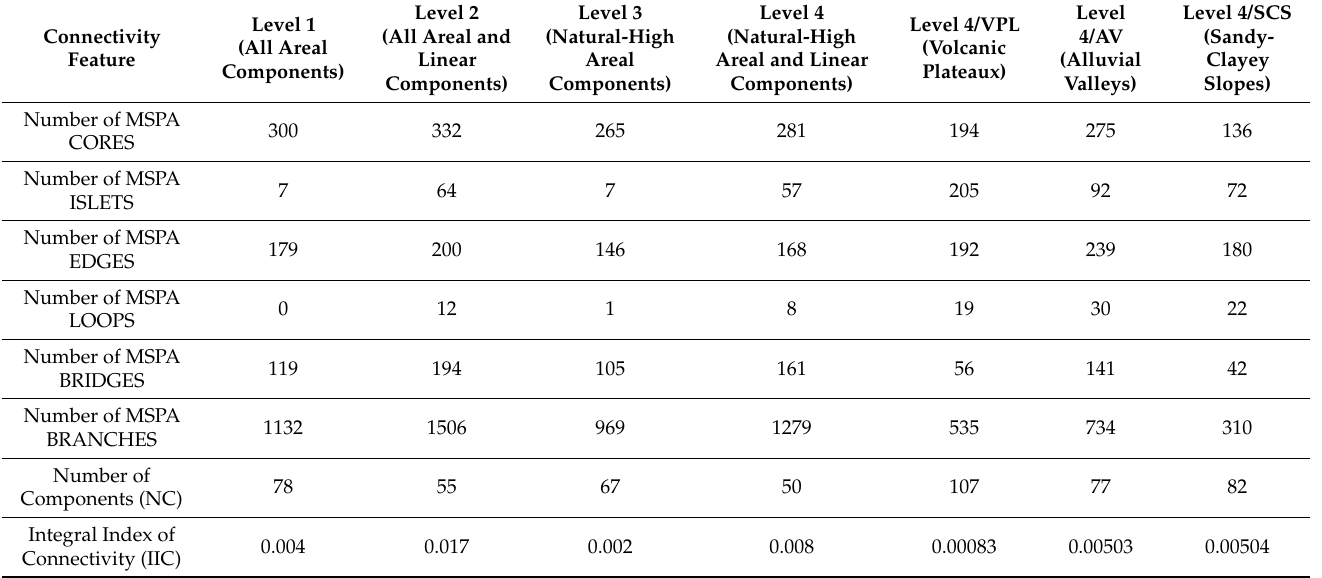
Table 2. Structural and functional connectivity features for the alternative levels of investigation. Note that, due to the “edge” parameter, many of the narrow forest ecosystems occurring along narrow slopes and valleys were eroded and fragmented. Therefore, the number of MSPA cores, branches, and bridges far exceeds the number of patches and linear elements in the original